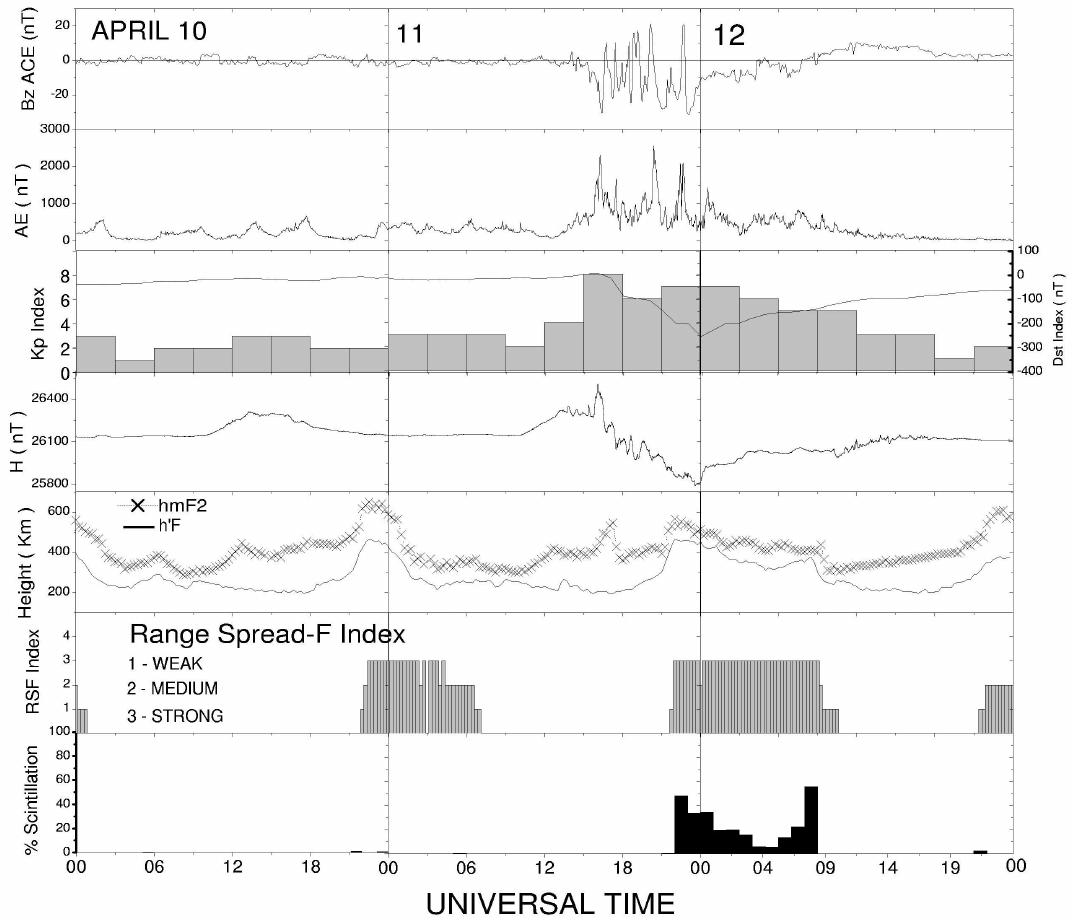
Fig. 1. IMF B z component in GSM coordinates provided by the ACE spacecraft (corrected to the propagation time up to the magnetopause boundary), AE auroral index, K p and D st magnetic indices, S˜ao Lu´ıs magnetometer H component, S˜ao Lu´ıs digisonde parameters hm F2 and h 0 F, and Range Spread F (RSF) index and Percentage of Occurrence of GPS amplitude scintillations with scintillation index S 4 > 0.1, from 10 to 12 April